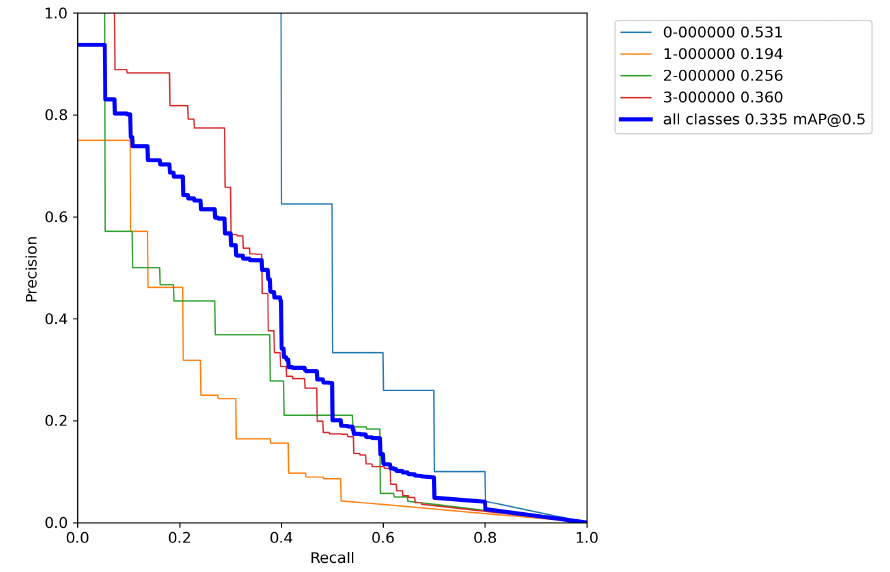
Figure A10. Model trained with classic augmentation techniques P–R curve—Experiment 5.